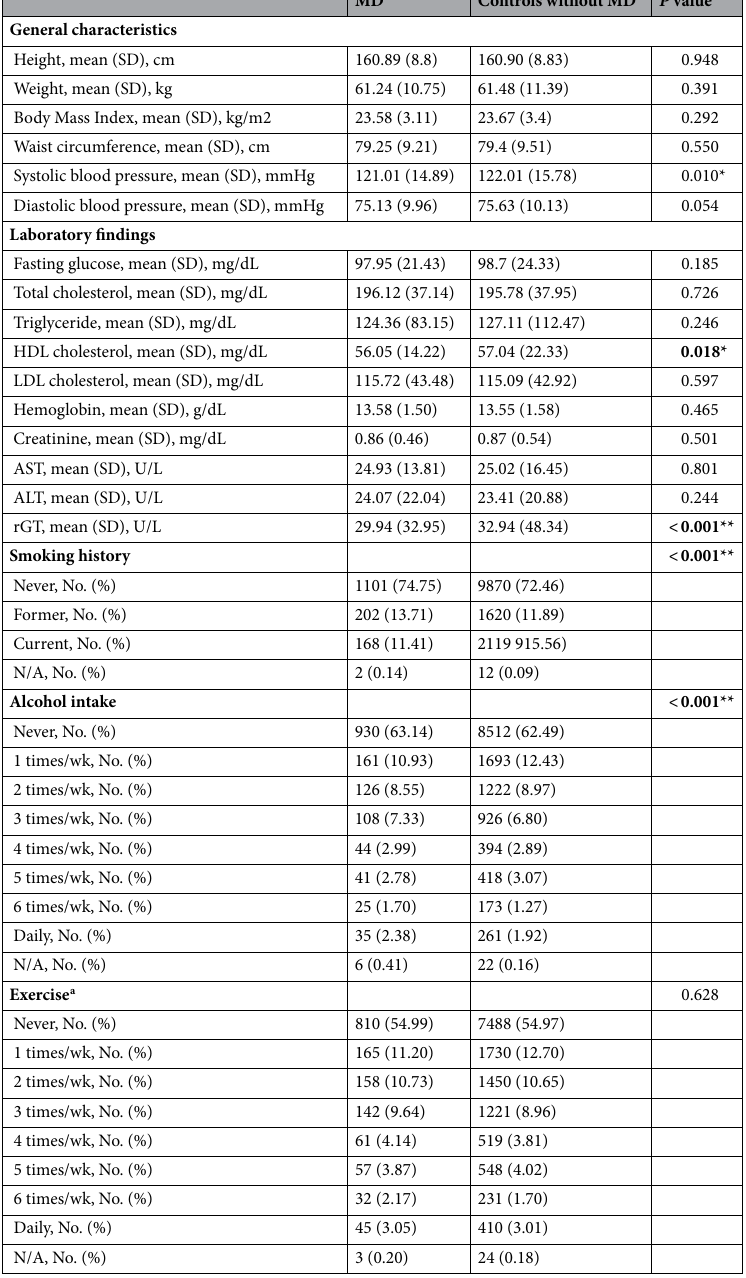
Table 4. Health screening data of participants with Ménière’s disease. Significant values are in [bold]. a 30 min or more of moderate-intensity exercise. MD Ménière’s disease, LDL Low-density lipoprotein, HDL High-density lipoprotein, AST Aspartate aminotransferase, ALT Alanine aminotransferase, rGT Gamma- glutamyltrans-